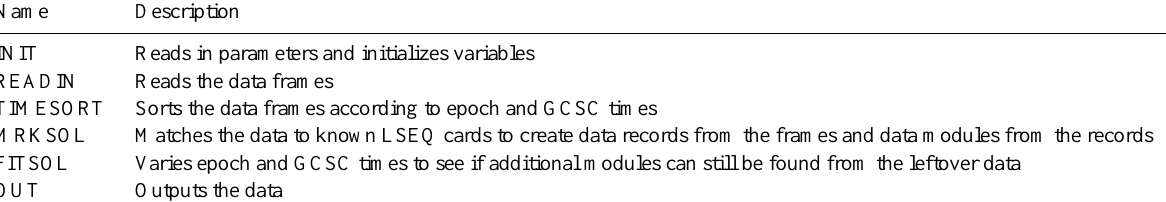
Table 2. Data time ordering (PREFEP).